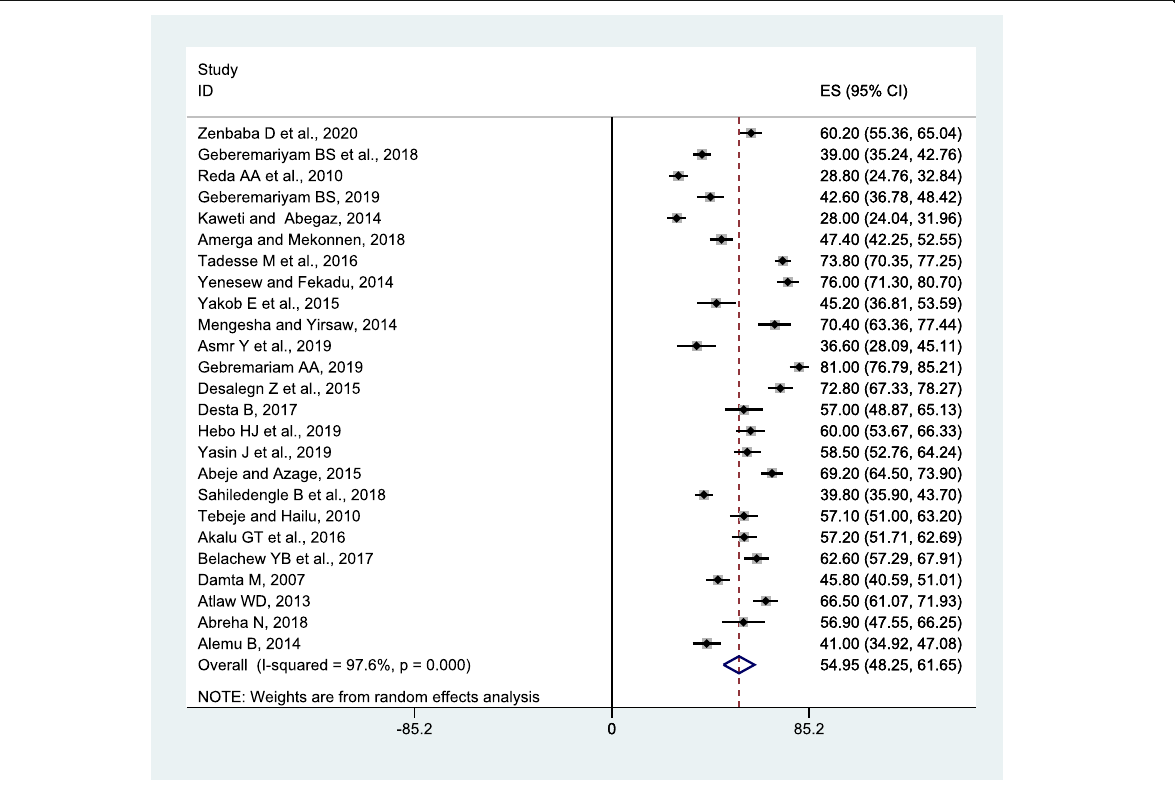
Fig. 3 Meta-analysis, lifetime prevalence of blood and body fluid exposure among healthcare workers in Ethiopia, 2007 –